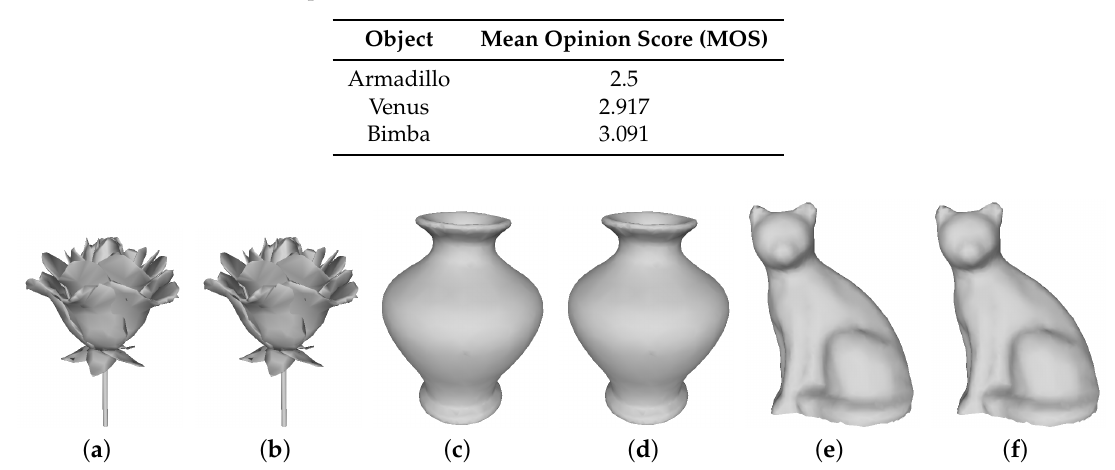
Table 2. Mean opinion score (MOS) for Armadillo, Venus, and Bimba objects taken from LIRIS-Mask [20] and LIRIS-EFPL-Gen-Purpose [21] databases.